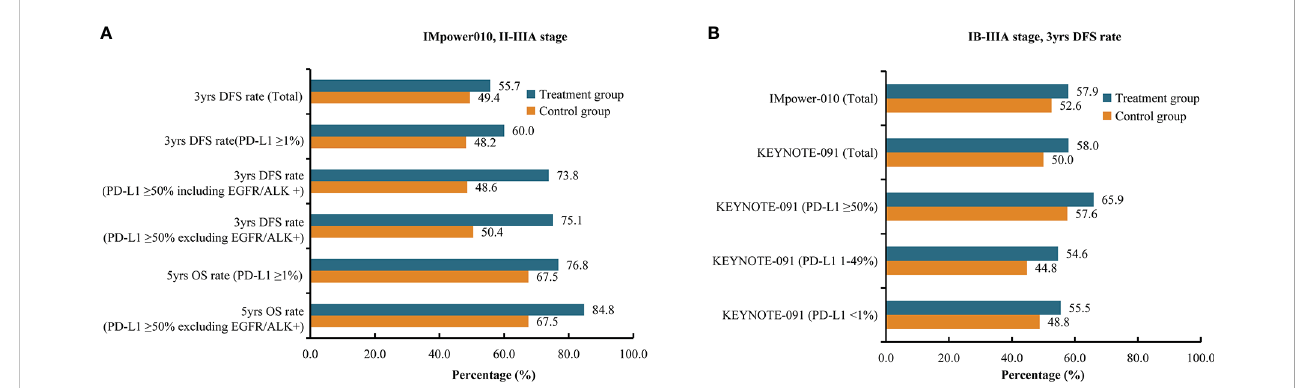
FIGURE 3 Summary of survival rates of clinical trials. (A) 3-year disease-free survival rates and 5-year overall survival rates of patients with stage II-IIIA non – small cell lung cancer in the IMpower010 trial. (B) 3-year disease-free survival rates of patients with stage IB-IIIA non-small cell lung cancer in the IMpower010 and KEYNOTE-091 trials. ALK, anaplastic lymphoma kinase; Chemo, chemotherapy; DFS, disease-free survival; EGFR, epidermal growth factor receptor; OS, overall survival; PD-L1, programmed death-ligand